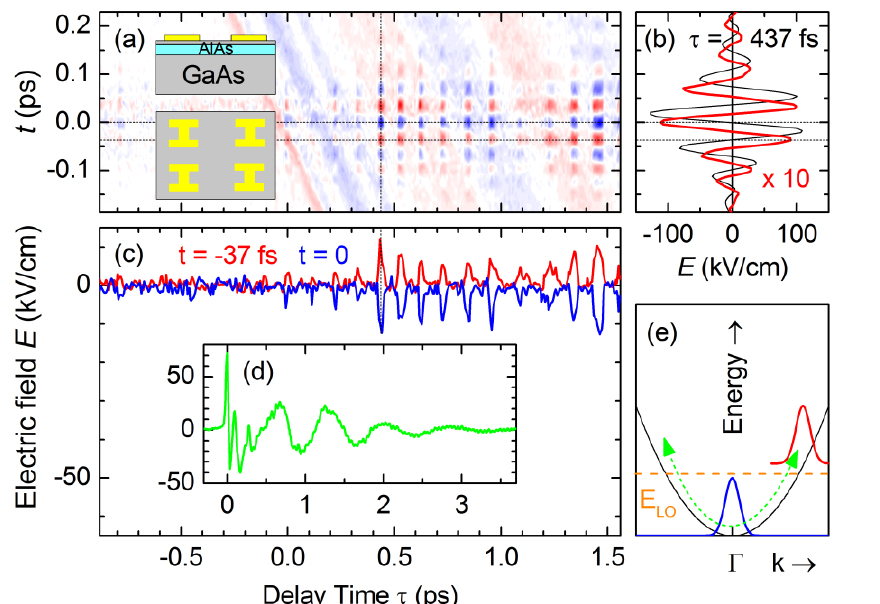
Fig 1. Two-dimensional (2D) nonlinear terahertz (THz) spectroscopy performed on an AlAs/GaAs nanostructure covered by a square array (periodicity 5 µm) of metallic dog-bone resonators as sketched in the inset. (a) Measured 2D scan of the nonlinearly emitted electric field E NL (t,  )=E both (t,  ) - 0.9 E THz (t,  ) - E MIR (t) (in reflection geometry) as a function of real time t and delay time  for applied THz [E THz (t,  =0) shown in panel (d)] and mid-infrared E MIR (t) pulses [black line in panel (b)]. For better orientation we subtracted only 90 percent of E THz (t,  ) making its phase fronts visible. (b) Red curve: nonlinearly emitted field for  = 437 fs [vertical dashed line in (a)]. (c) E NL (t = -37 fs,  ) (red line) and E NL (t = 0,  ) (blue line) as a function of  [horizontal dashed lines in (a)]. (e) LO phonon (energy: orange dashed line) amplification mechanism illustrated in the conduction band structure of GaAs (black parabola). Electrons (blue and red distribution functions) generated by interband tunneling are moved around in k space by the large vector potential 𝐴(𝑡, 𝜏) = ∫ 𝐸 𝑇𝐻𝑧 (𝑠, 𝜏) 𝑑𝑠 𝑡 of the −∞ THz pulse thereby creating at some instants of time an inversion situation for the stimulated emission of optical